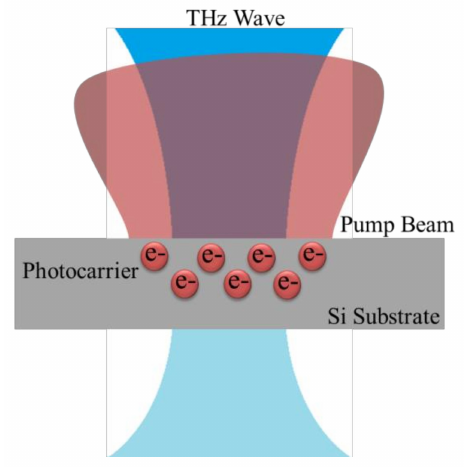
Figure 1. Schematic of the optically tunable THz